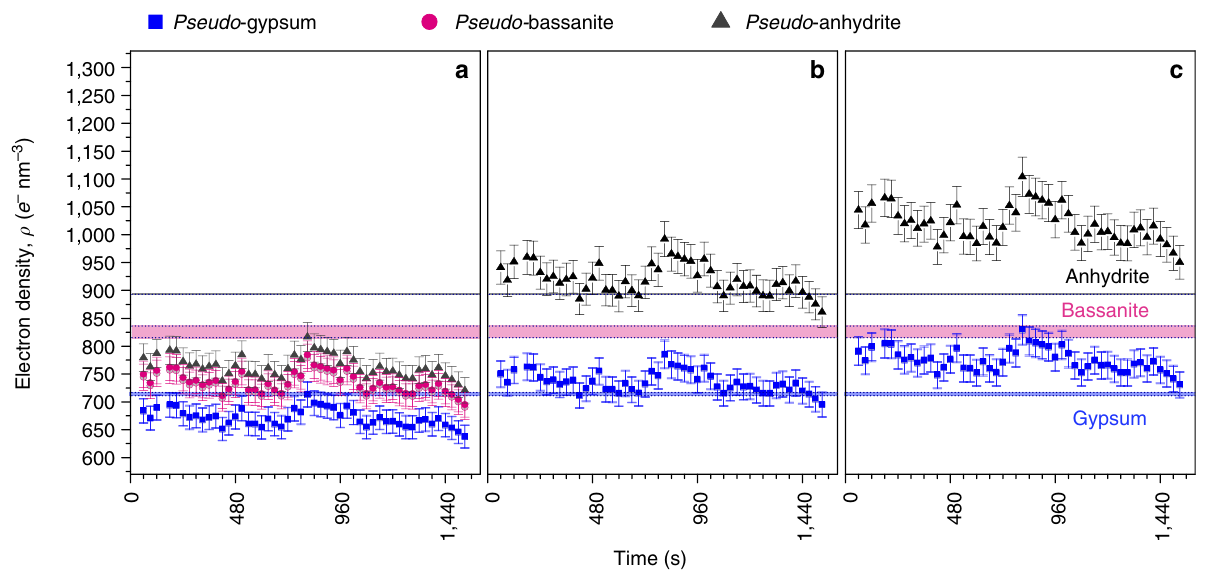
Figure 4 | Electron densities for CaSO 4 pseudo-phases based on SAXS. The values as a function of time were calculated based on the corresponding volume fractions of the known crystalline phases: ( a ) not taking into account the bulk solubility; ( b ) taking into account bulk solubility in pure water; ( c ) taking into account bulk solubility in a 100-mmoll (cid:3) 1 NaCl solution. The horizontal bands indicate the range of electron densities expected for each given CaSO 4 polymorph. Details of how the electron density values were calculated can be found in Supplementary Note 9 and Supplementary Table